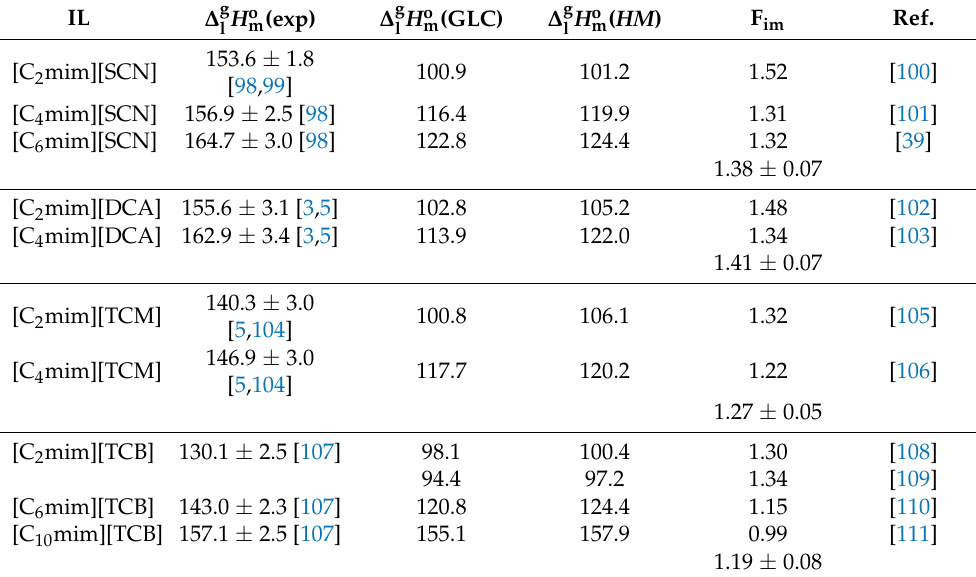
Table 6. [C n mim][Anion] series with cyano-containing anions: comparison of ∆ g derived according to Equations (5) and (6) with experimental results from conventional methods a